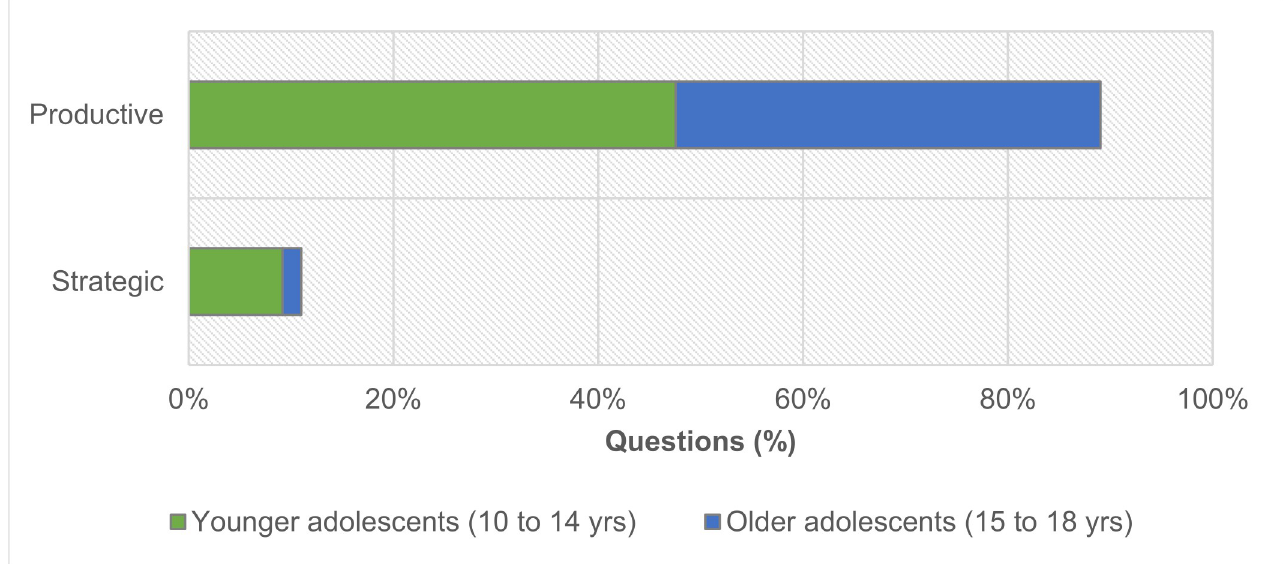
Fig 7. Distribution of valid participant questions (n = 164) according to the approach adopted in questioning by age group. In total, younger participants generated 93 questions, and older participants generated 71 questions.